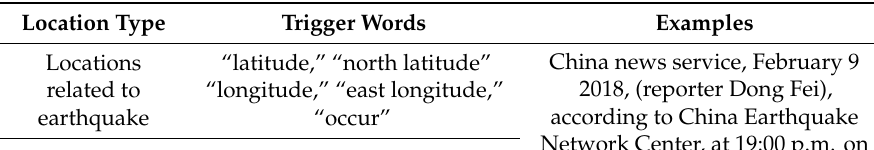
Table 3. Location trigger dictionary.